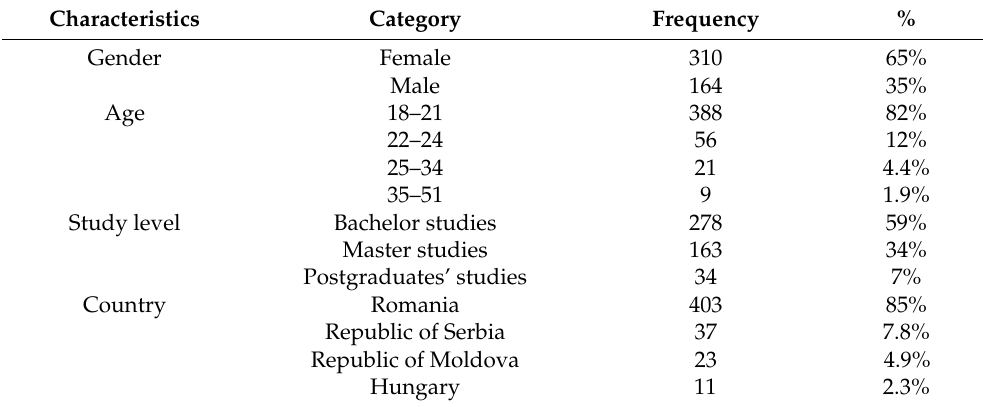
Table 1. Respondents’ information.